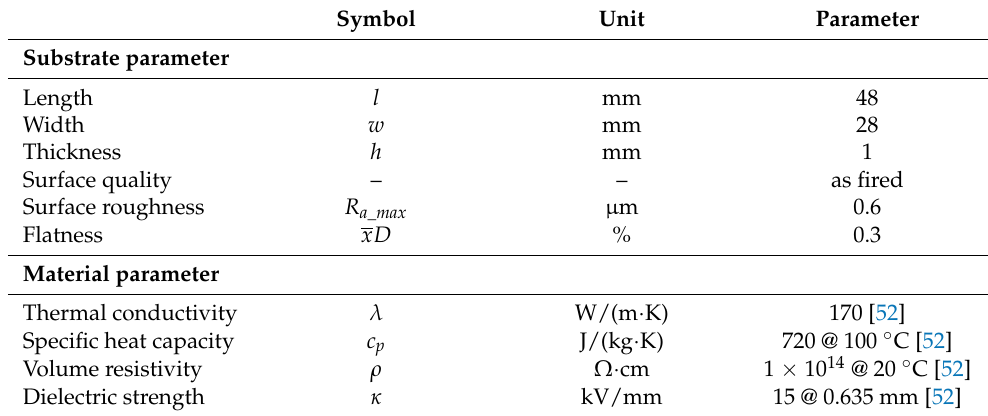
Table 4. Substrate and material parameter of CeramTec Alunit ® 170 C.